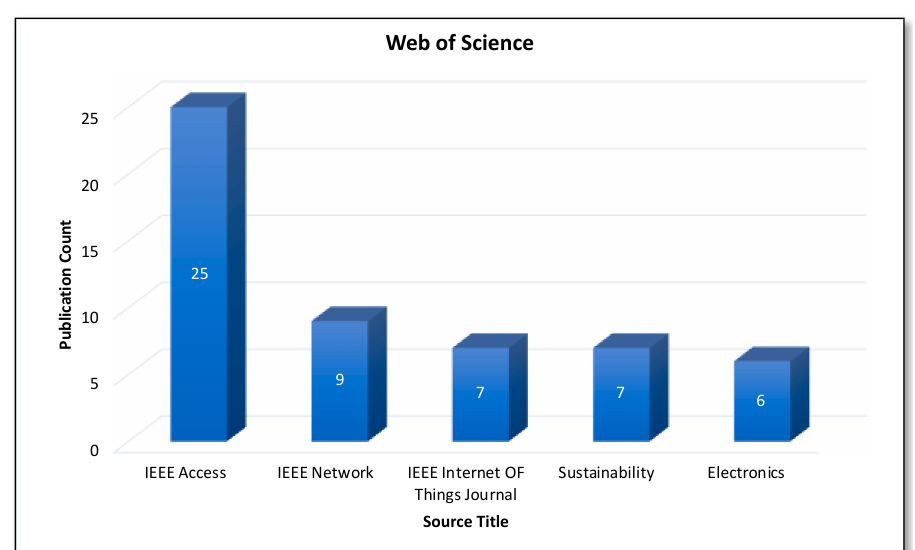
Figure 11. Analysis of publications by source (Scopus database).